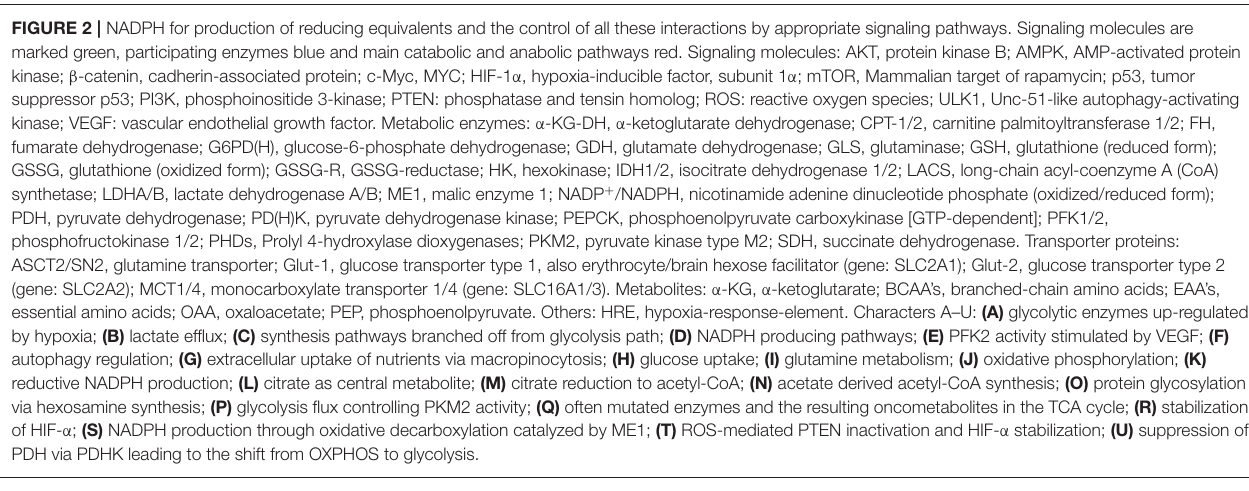
FIGURE 2 | NADPH for production of reducing equivalents and the control of all these interactions by appropriate signaling pathways. Signaling molecules are marked green, participating enzymes blue and main catabolic and anabolic pathways red. Signaling molecules: AKT, protein kinase B; AMPK, AMP-activated protein kinase; β -catenin, cadherin-associated protein; c-Myc, MYC; HIF-1 α , hypoxia-inducible factor, subunit 1 α ; mTOR, Mammalian target of rapamycin; p53, tumor suppressor p53; PI3K, phosphoinositide 3-kinase; PTEN: phosphatase and tensin homolog; ROS: reactive oxygen species; ULK1, Unc-51-like autophagy-activating kinase; VEGF: vascular endothelial growth factor. Metabolic enzymes: α -KG-DH, α -ketoglutarate dehydrogenase; CPT-1/2, carnitine palmitoyltransferase 1/2; FH, fumarate dehydrogenase; G6PD(H), glucose-6-phosphate dehydrogenase; GDH, glutamate dehydrogenase; GLS, glutaminase; GSH, glutathione (reduced form); GSSG, glutathione (oxidized form); GSSG-R, GSSG-reductase; HK, hexokinase; IDH1/2, isocitrate dehydrogenase 1/2; LACS, long-chain acyl-coenzyme A (CoA) synthetase; LDHA/B, lactate dehydrogenase A/B; ME1, malic enzyme 1; NADP + /NADPH, nicotinamide adenine dinucleotide phosphate (oxidized/reduced form); PDH, pyruvate dehydrogenase; PD(H)K, pyruvate dehydrogenase kinase; PEPCK, phosphoenolpyruvate carboxykinase [GTP-dependent]; PFK1/2, phosphofructokinase 1/2; PHDs, Prolyl 4-hydroxylase dioxygenases; PKM2, pyruvate kinase type M2; SDH, succinate dehydrogenase. Transporter proteins: ASCT2/SN2, glutamine transporter; Glut-1, glucose transporter type 1, also erythrocyte/brain hexose facilitator (gene: SLC2A1); Glut-2, glucose transporter type 2 (gene: SLC2A2); MCT1/4, monocarboxylate transporter 1/4 (gene: SLC16A1/3). Metabolites: α -KG, α -ketoglutarate; BCAA’s, branched-chain amino acids; EAA’s, essential amino acids; OAA, oxaloacetate; PEP, phosphoenolpyruvate. Others: HRE, hypoxia-response-element. Characters A–U: (A) glycolytic enzymes up-regulated by hypoxia; (B) lactate efflux; (C) synthesis pathways branched off from glycolysis path; (D) NADPH producing pathways; (E) PFK2 activity stimulated by VEGF; (F) autophagy regulation; (G) extracellular uptake of nutrients via macropinocytosis; (H) glucose uptake; (I) glutamine metabolism; (J) oxidative phosphorylation; (K) reductive NADPH production; (L) citrate as central metabolite; (M) citrate reduction to acetyl-CoA; (N) acetate derived acetyl-CoA synthesis; (O) protein glycosylation via hexosamine synthesis; (P) glycolysis flux controlling PKM2 activity; (Q) often mutated enzymes and the resulting oncometabolites in the TCA cycle; (R) stabilization of HIF- α ; (S) NADPH production through oxidative decarboxylation catalyzed by ME1; (T) ROS-mediated PTEN inactivation and HIF- α stabilization; (U) suppression of PDH via PDHK leading to the shift from OXPHOS to